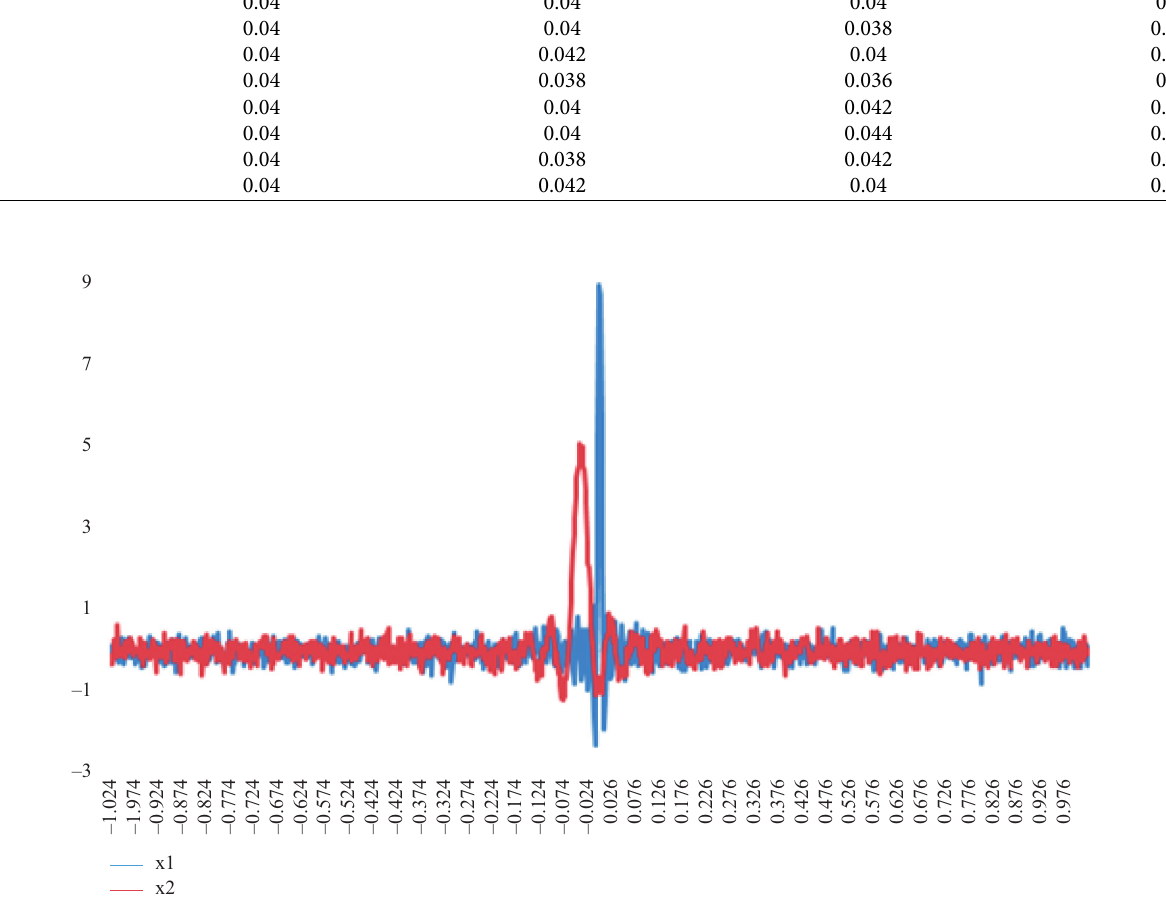
Figure 8: Illustration of signal with added noise ( σ � 0.2).